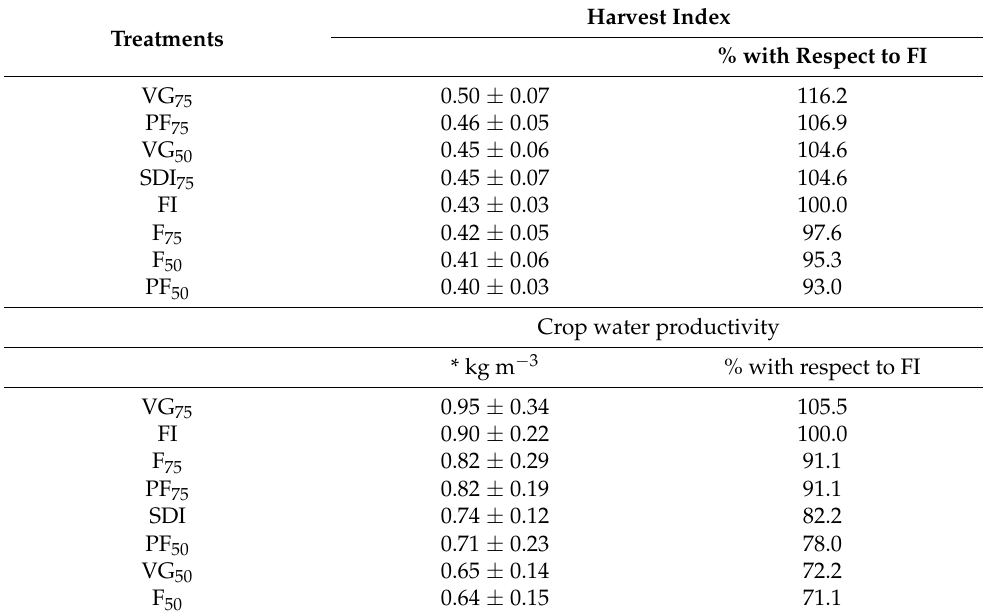
Table 8. Differences (%) in harvest index (HI) and crop water productivity (CWP) among irrigation treatments. Treatments